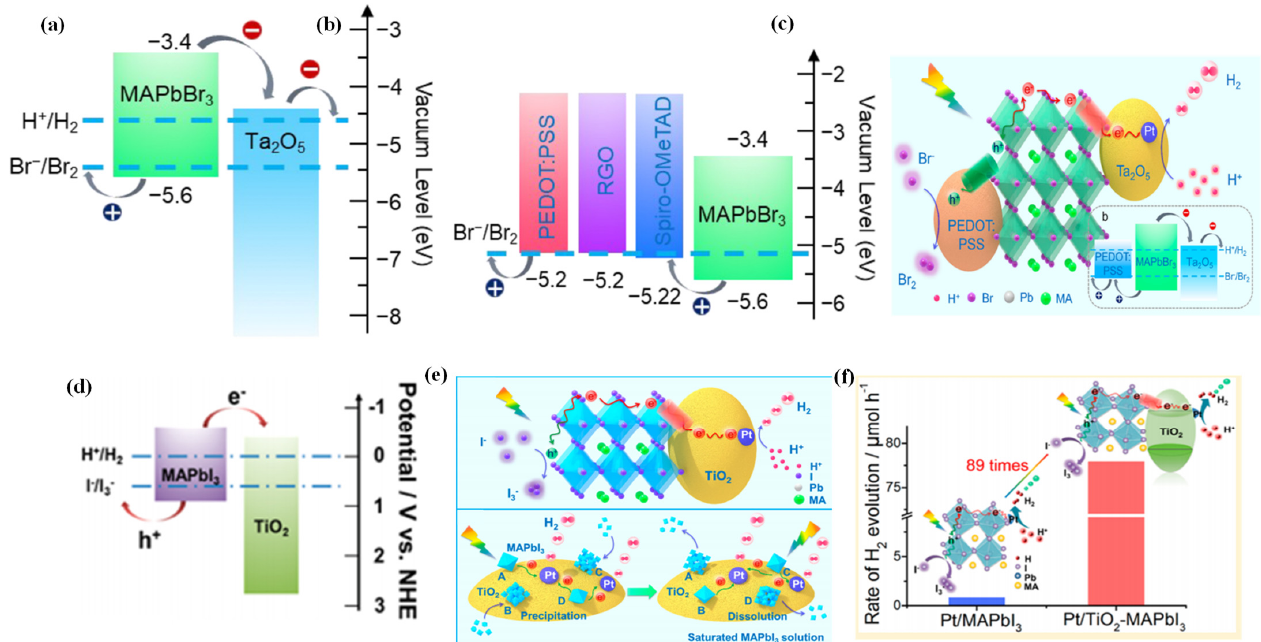
Figure 5. ( a ) Schematic energy levels of MAPbBr 3 and Ta 2 O 5 and the redox potentials for HBr splitting reaction. ( b ) Energy level diagrams of MAPbBr 3 and hole-transporting materials. ( c ) Schematic illustration of the reaction mechanism for MAPbBr 3 with Pt/Ta 2 O 5 and PEDOT:PSS as the electron- and hole-transporting channels, respectively. ( d ) Schematic diagrams of energy band of MAPbI 3 and TiO 2 . ( e ) Schematic illustration of photocatalytic HI splitting for H 2 evolution by Pt/TiO 2 - MAPbI 3 hybrid system under visible light irradiation. ( f ) Comparison of H 2 evolution activity over Pt/MAPbI 3 and Pt/TiO 2 -MAPbI 3 . ( a – c ) Reproduced with permission [115]. Copyright: 2019, American Chemical Society. ( d – f ) Reproduced with permission [42]. Copyright: 2018, American Chemical